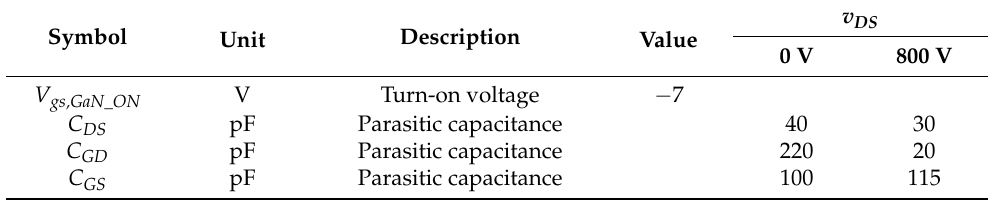
Table 6. Characteristics summary of the D-mode GaN HEMT under 1 MHz